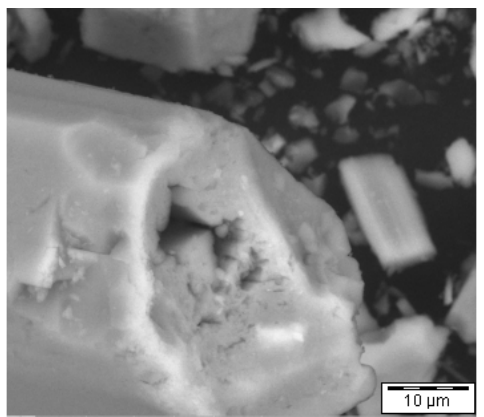
Figure 11. Voids formed in technical-produced α -HH (steam autoclave).